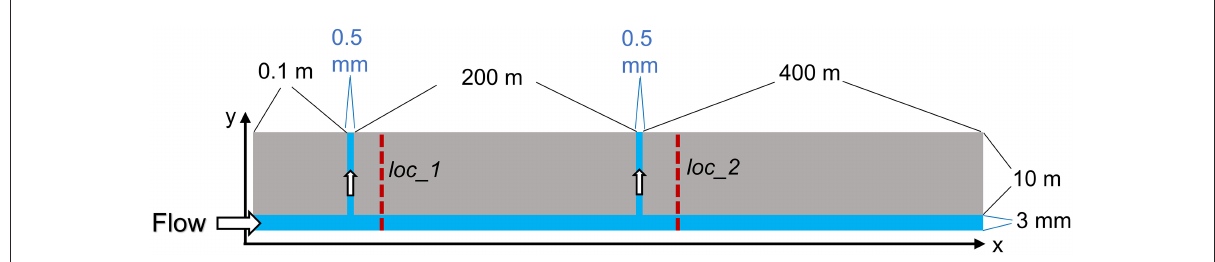
FIGURE2 Illustration of the fracture layout for the 2D model. The illustration is not drawn in scale. All flow-through models were run for 7 days of reaction time. Loc_1 and Loc_2 refer to 1D profiles extracted from the 2D simulations for